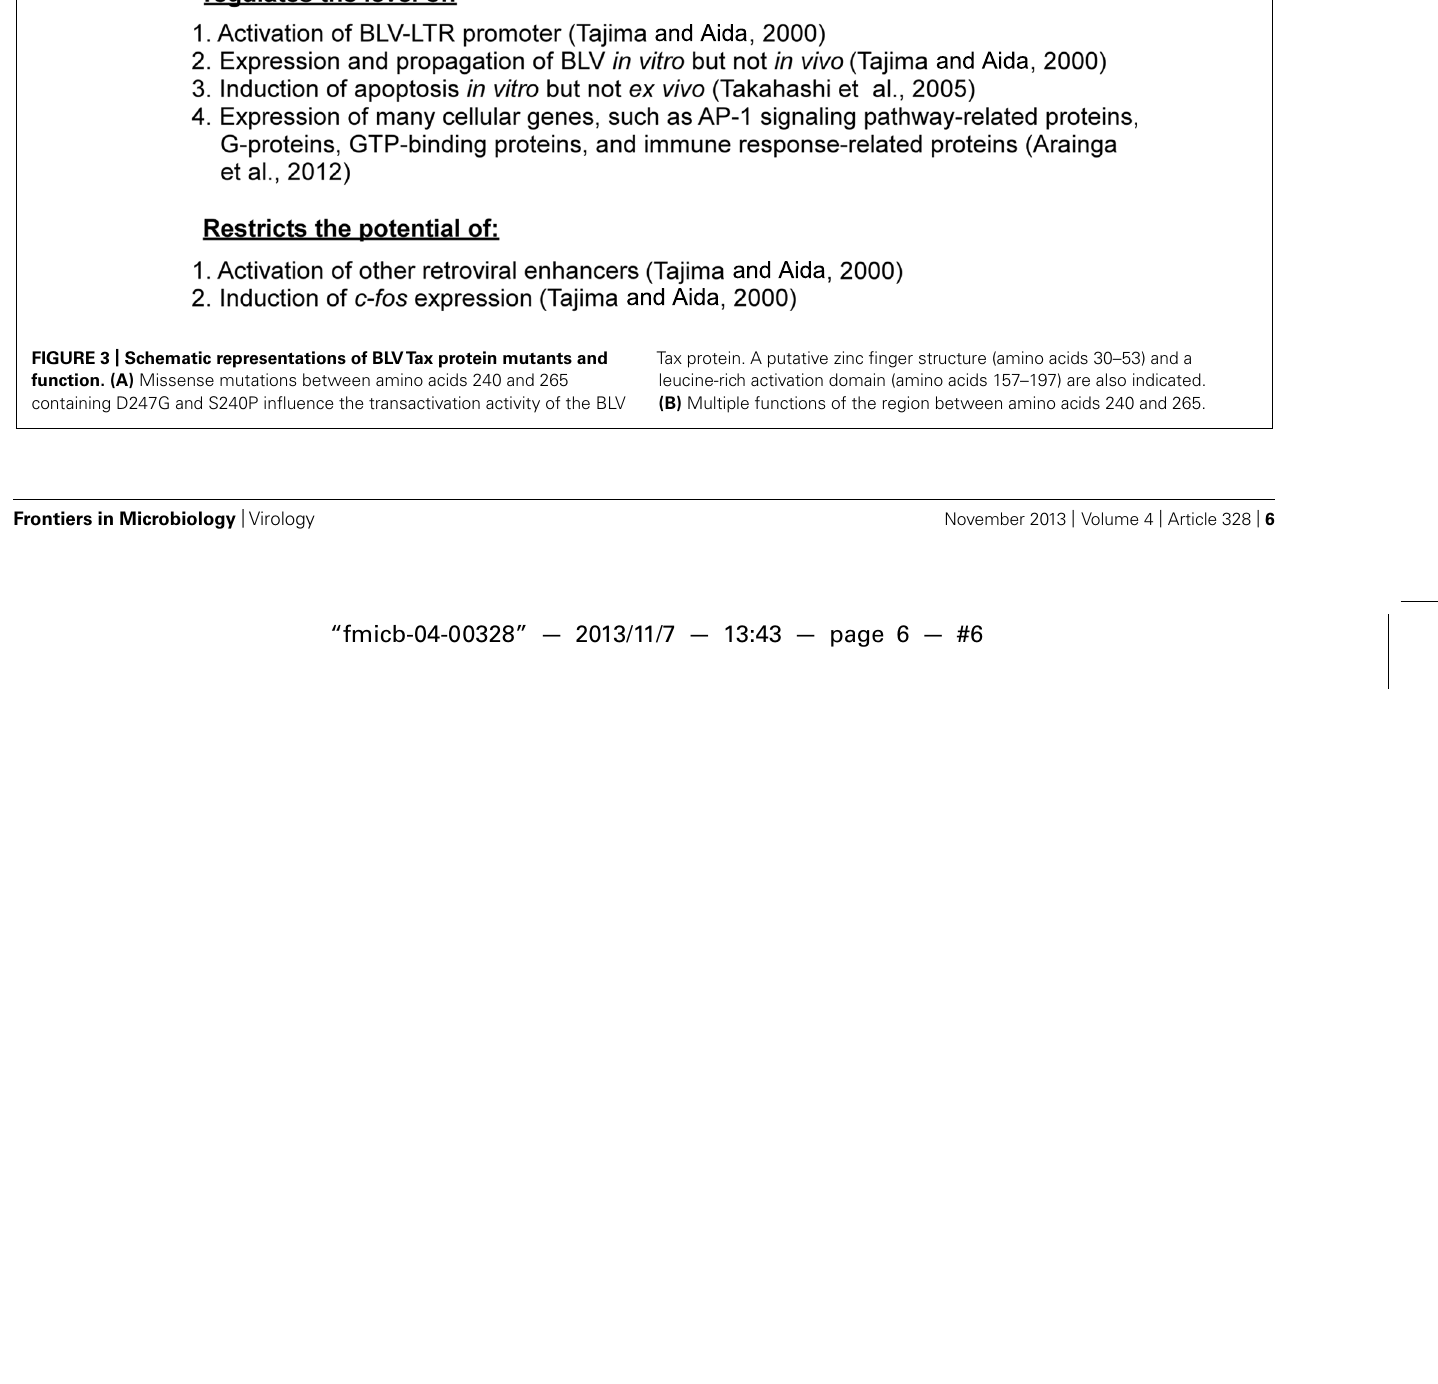
FIGURE 3 | Schematic representations of BLVTax protein mutants and function. (A) Missense mutations between amino acids 240 and 265 containing D247G and S240P influence the transactivation activity of the BLV